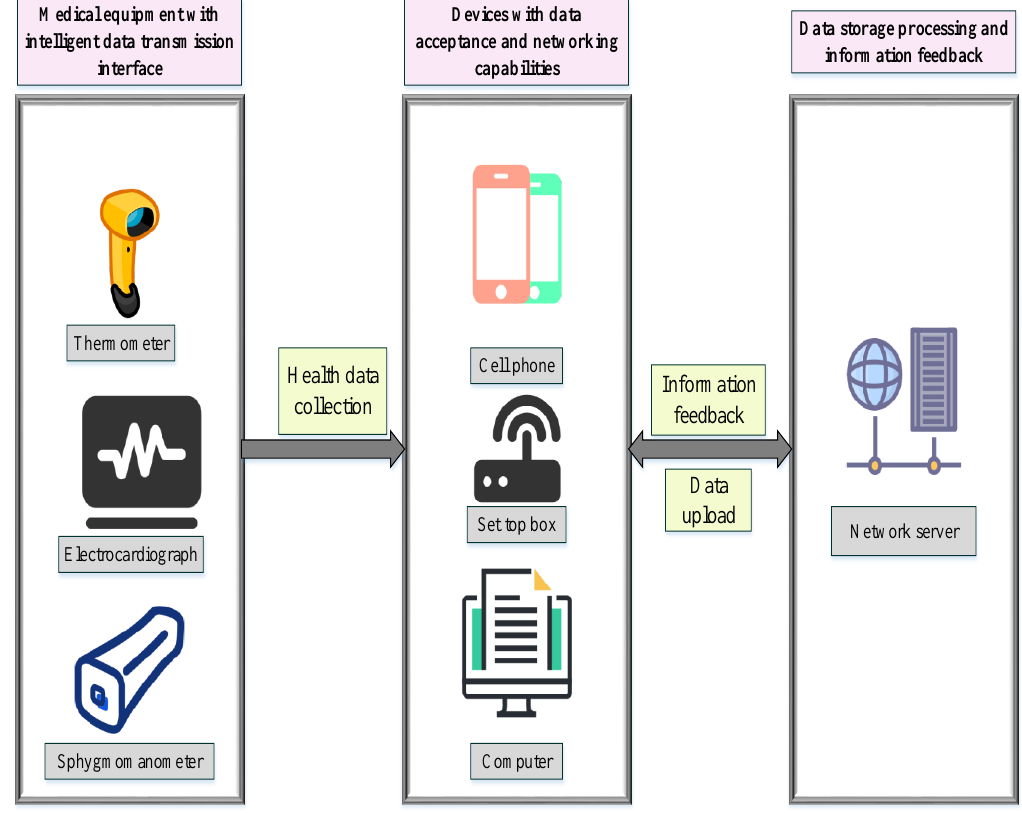
Figure 7. WHSM system based on IoT.